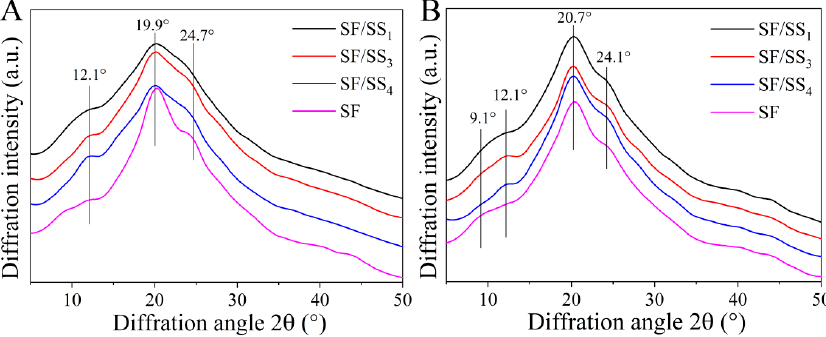
Figure 5. XRD patterns of SF/SS composites. ( A ) No treatment, ( B ) Ethanol treatment.